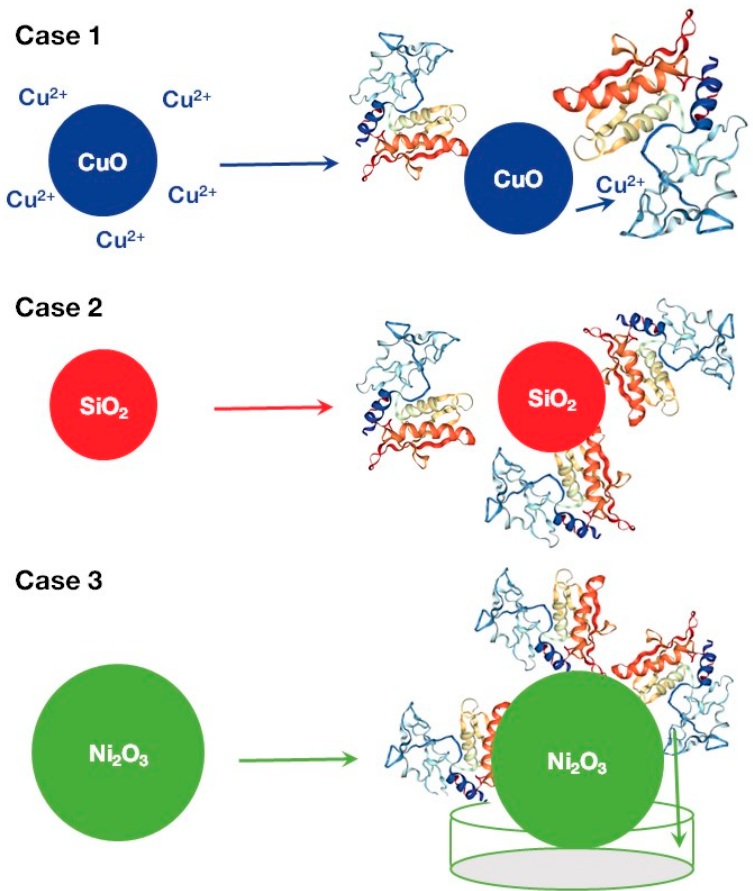
Figure 4. Schematic representation of mechanisms of the zebrafish hatching metalloprotease (ZHE1) inhibition induced by metal oxide nanoparticles.